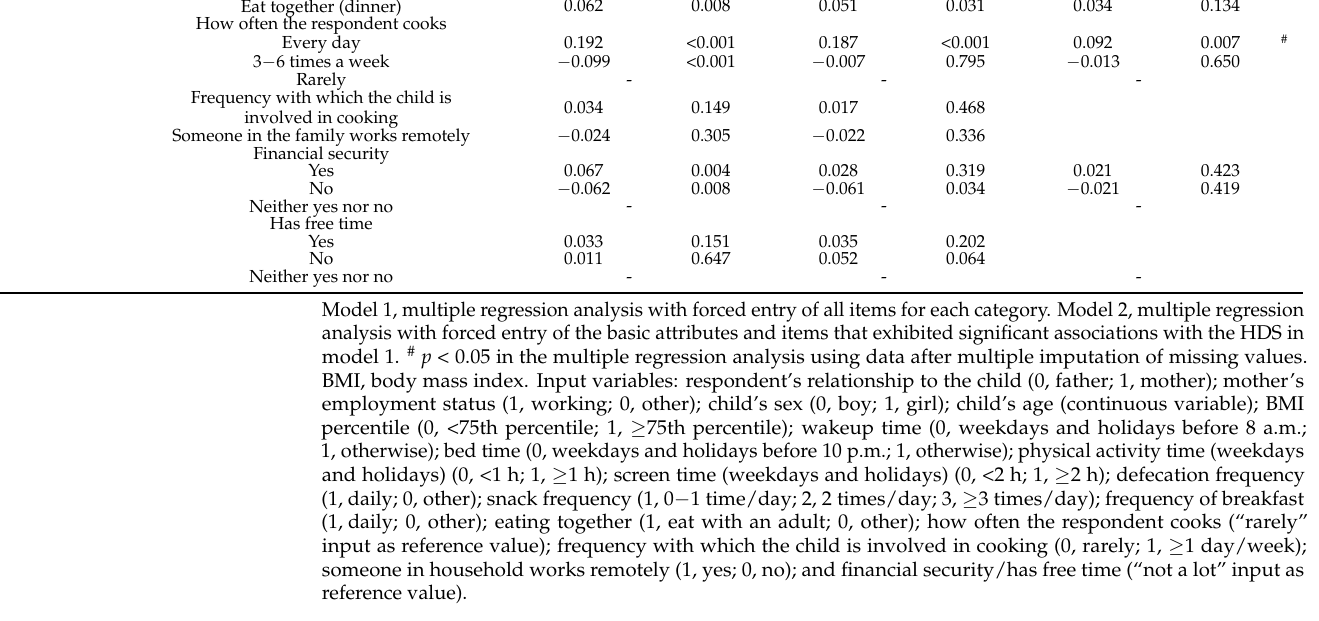
Table 5. Multiple logistic regression analysis with the change in healthy diet score (C-HDS) as the dependent